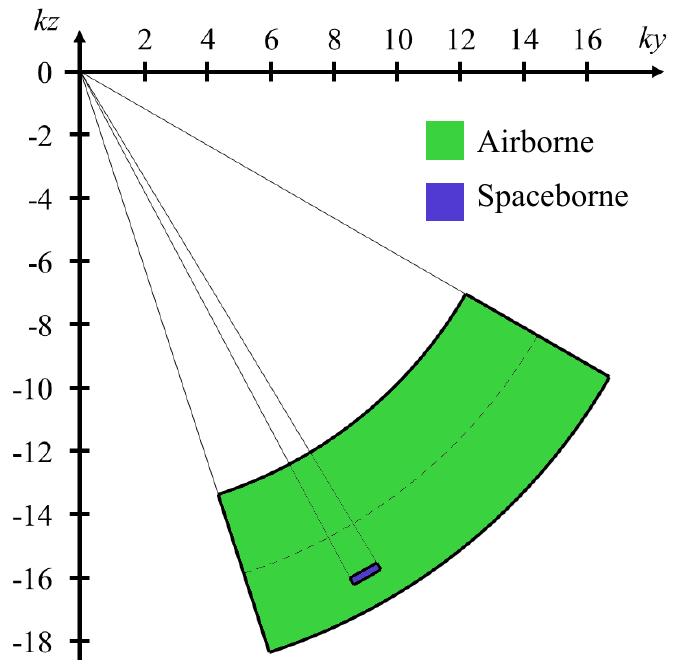
Figure 4. Wavenumbers enlightened by an airborne (green) and spaceborne SAR systems (purple) in the { ky , kz } domain. The horizontal axis represents the transformed variable of the ground range coordinate whereas the vertical axis of the elevation; y and z in Figure 1 respectively. The airborne system here represented spans a wider range of look angles, has a greater bandwidth and a lower central frequency than the spaceborne system.